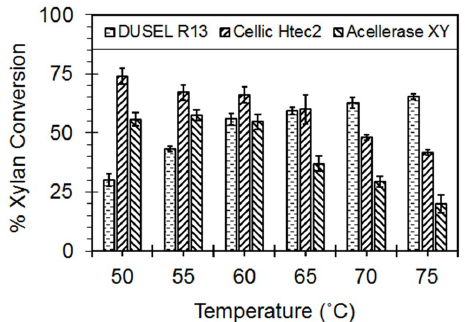
Figure 10. Hydrolysis of the beechwood xylan by DUSELR13, and comparative analysis of the hydrolytic activity with Cellic HTec2 and Accellerase XY. The percentage xylan conversion is calculated on the basis of the sugar released from 1 g of xylan, with complete hydrolysis of xylan considered as 100%. The values are mean of triplicate experiments and the error bars represent ± SD of the means with n = 3.